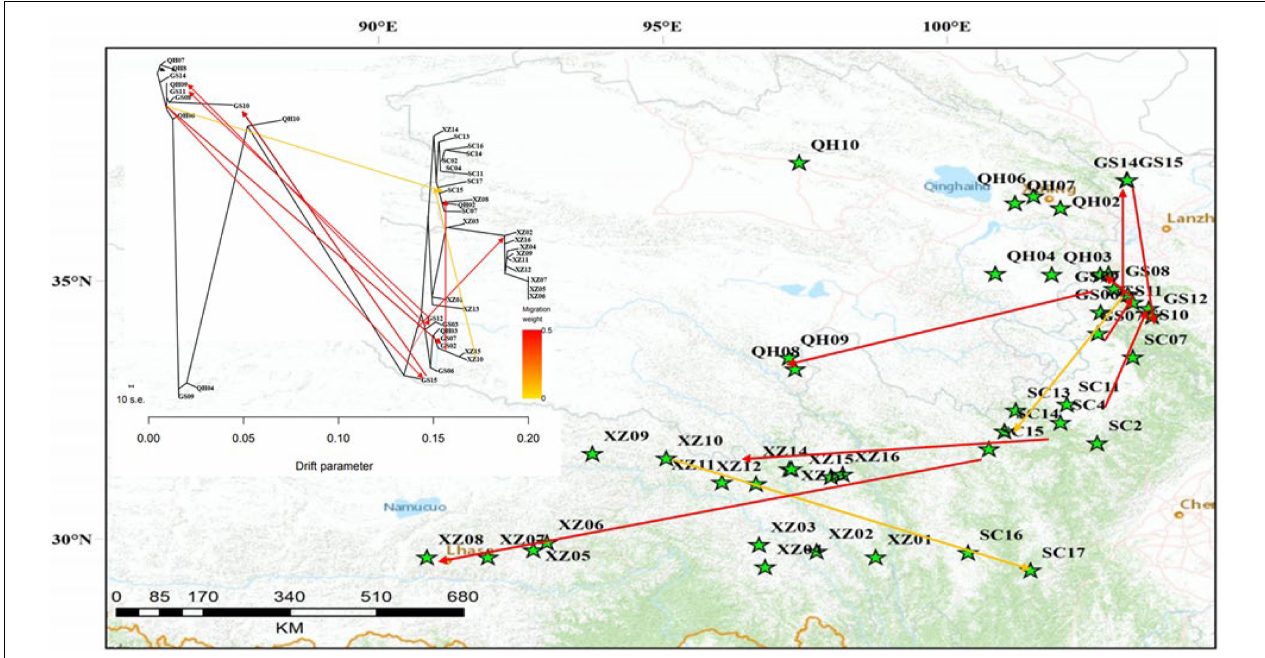
FIGURE 5 | Phylogenetic network of the genetic relationships among the E. sibiricus populations with different possible migration events ( m = 10, six migration events) inferred from TreeMix analysis. The graph shows the topology and branch lengths according to the drift parameter. Migration arrows were colored according to their weight. The scale bar shows 10 times the average standard error (s.e.) of the entries in the sample covariance matrix W.